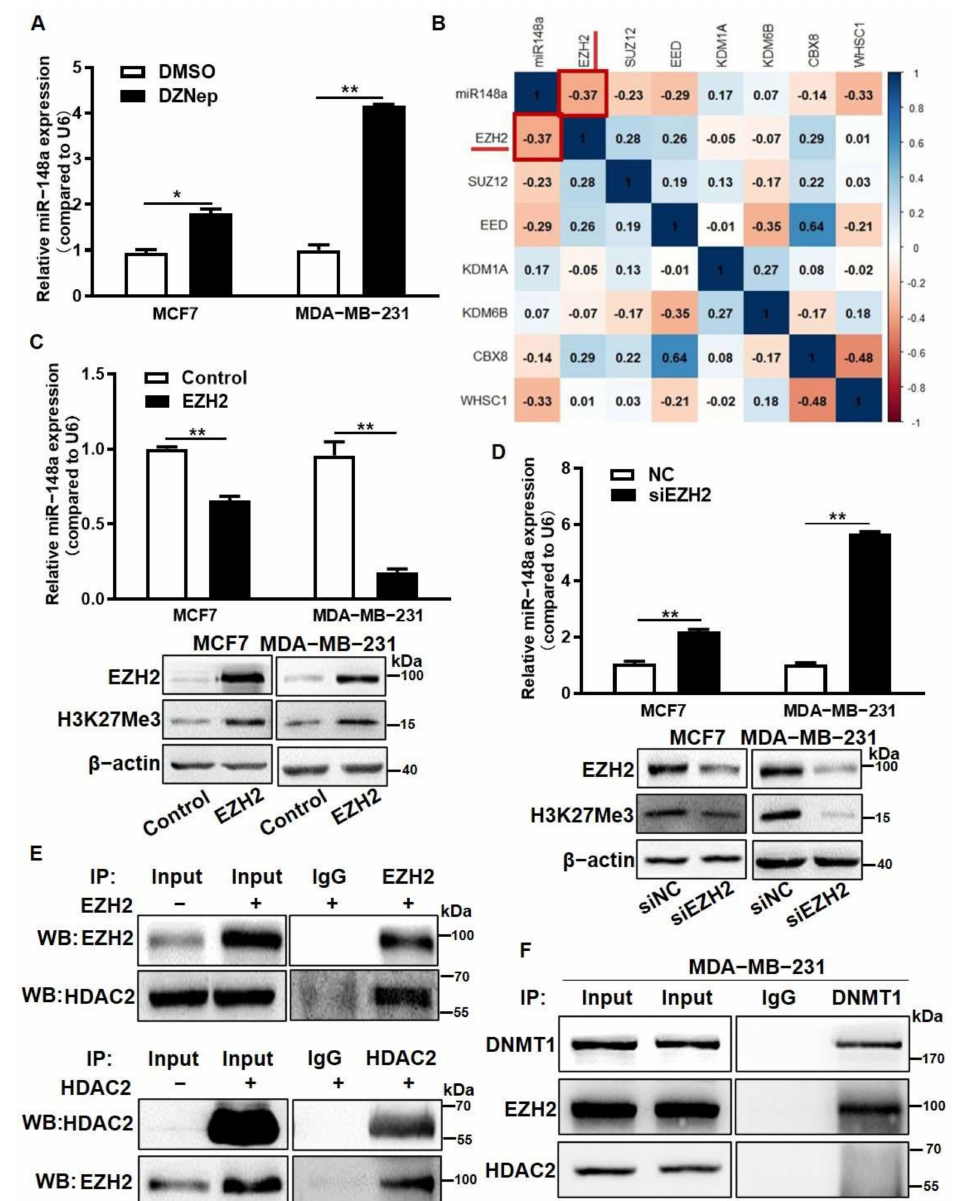
Figure 4. EZH2 overexpression inhibited miR-148a expression by recruiting HDAC2. ( A ) The miR-148a expression levels were detected in DZNep-treated MCF7 and MDA-MB-231 cells by qRT- PCR. ( B ) The correlation analysis between miR-148a and histone methylation modification-related proteins (correlation: Pearson). ( C , D ) The expression levels of miR-148a (upper) and the protein expression levels of H3K27Me3 (lower) were detected in EZH2 overexpression ( C ) or inhibition ( D ) groups by qRT-PCR and Western blotting (three independent experiments and each performed for three times). ( E ) Control, HDAC2, and EZH2 plasmids were overexpressed in MDA-MB-231 cells. Co-immunoprecipitation (Co-IP) assay was performed after 48 h, and Western blotting assay was used to measure EZH2 and HDAC2. ( F ) Co-IP assay was carried out in MDA-MB-231 cells. The levels of DNMT1, EZH2 and HDAC2 were detected in the input, IgG, and IP groups by Western blotting. Student’s t -test was used for comparison between two groups in ( A , C , D ). * Indicates significant difference at p < 0.05 and ** indicates significant difference at p < 0.01. Original Blots see Supplementary File